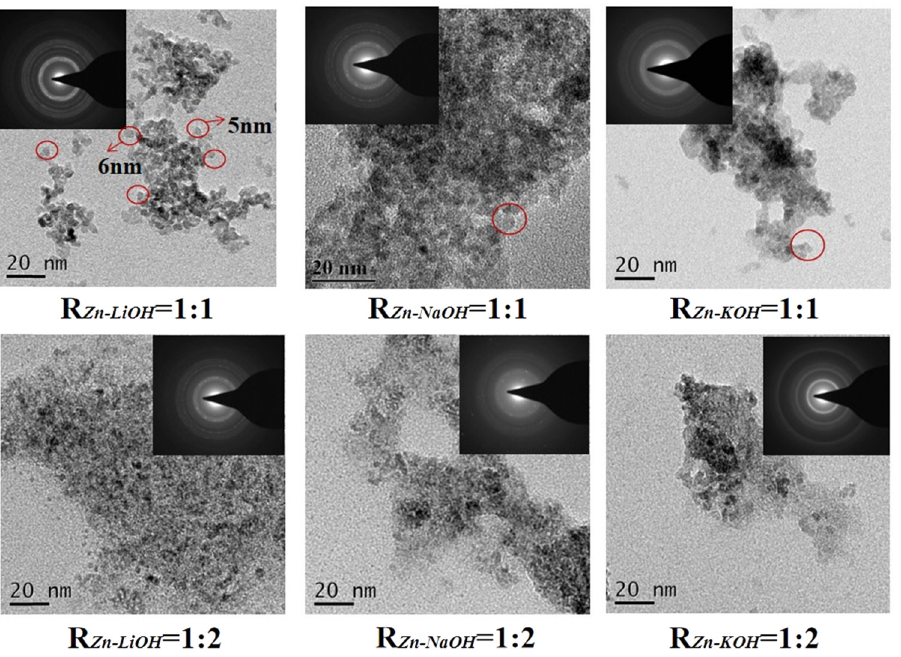
Figure 3: TEM image and SAED image of ZnO QDs synthesized with di ff erent alkali bases and R Zn − OH values.